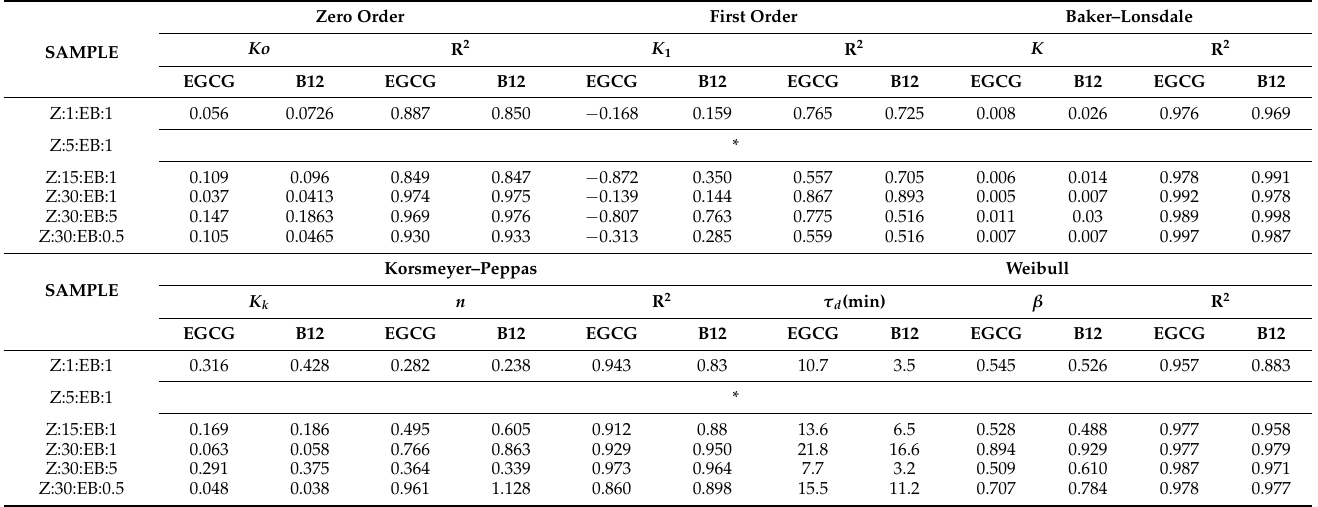
Table 2. Parameters and correlation coefficients of each equation from the kinetic models of the zein microstructures loaded with (EGCG + VitB12). Samples marked with * was not possible to fit any model due to the fast core